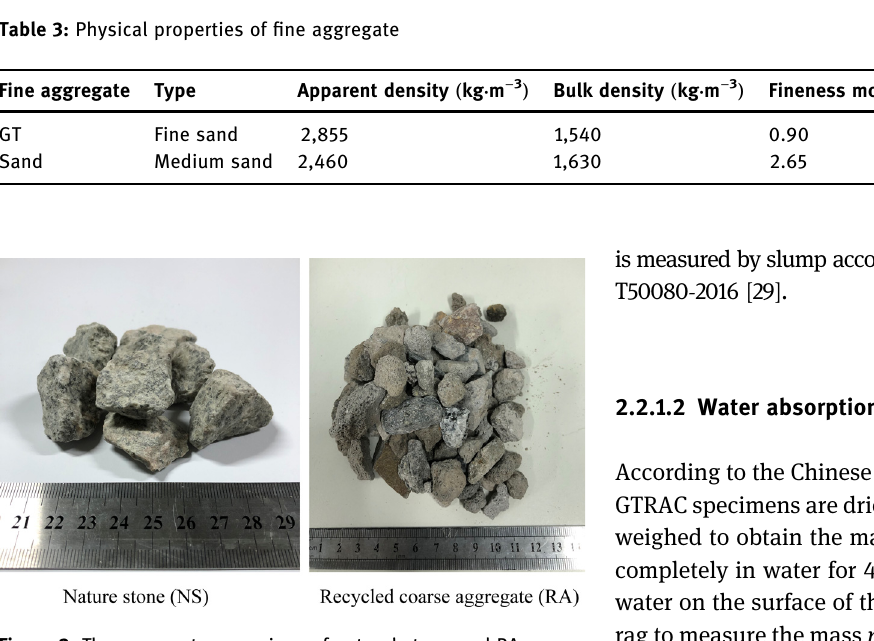
Figure 3: The apparent comparison of natural stone and RA.